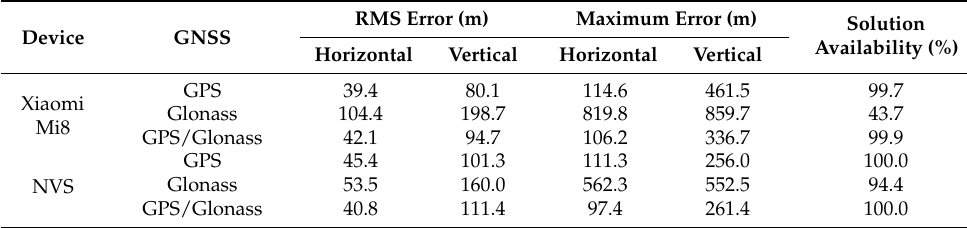
Table 4. Comparison between Xiaomi Mi8 and NVS, without RAIM application.